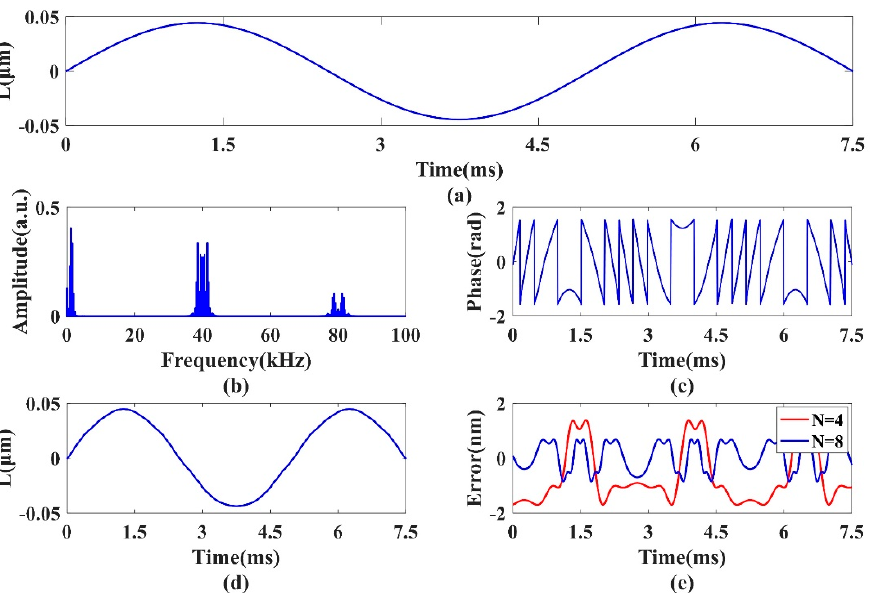
Figure 4. Displacement reconstruction results with A = λ /12. ( a ) Simulated displacement of the outer objective. ( b ) Frequency spectrum of SMI signal with N = 8. ( c ) Wrapped phase with N = 8. ( d ) Displacement reconstruction of N = 8. ( e ) Displacement reconstruction error of N = 4 and N = 8.